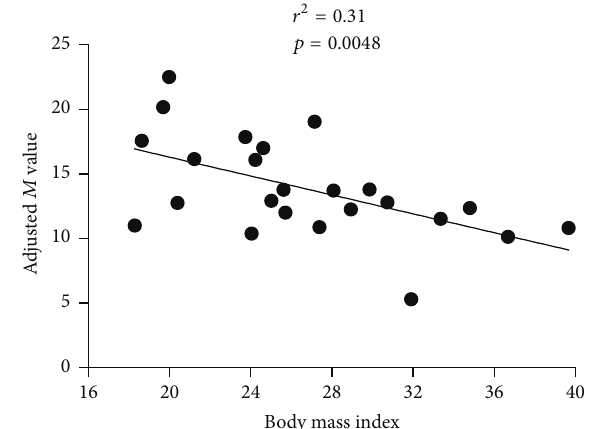
Figure 2: Graph showing the regression of the adjusted 𝑀 value against